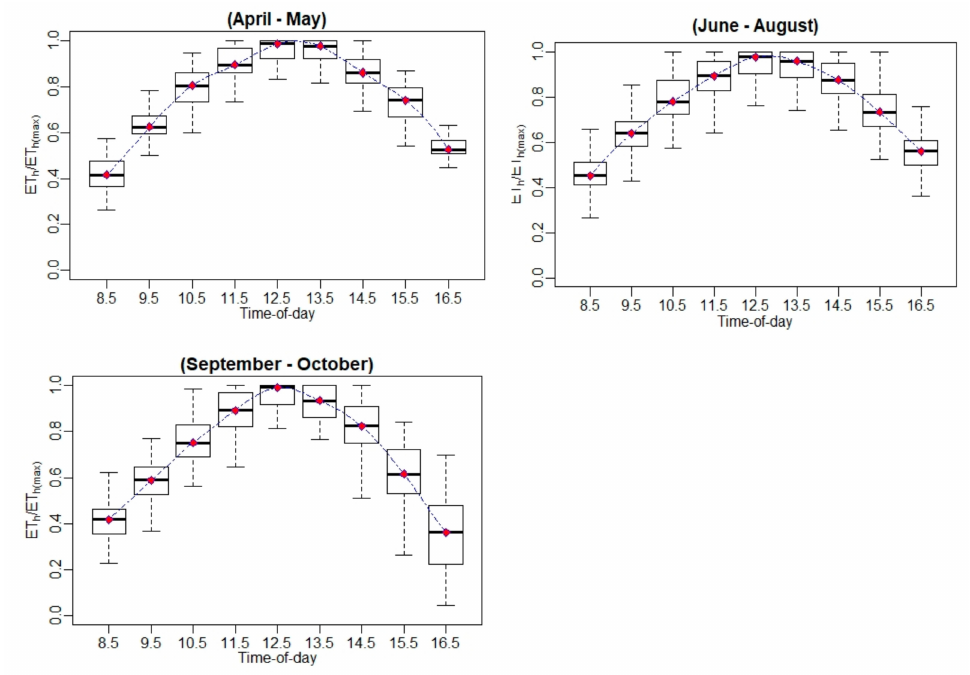
Figure A6. Hourly ET -to-maximum hourly ET ratio ( ET h /ET h(max) ) variation using EC